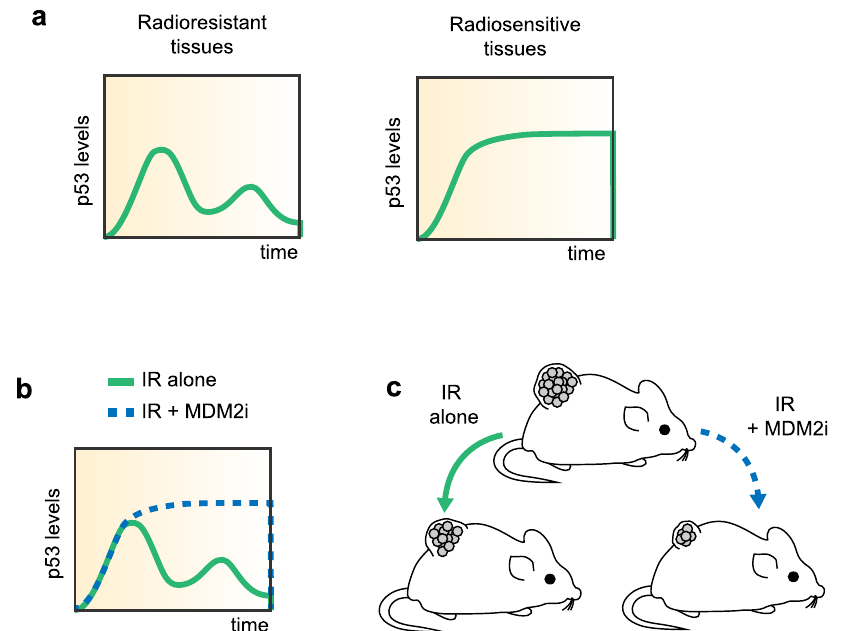
Fig. 5 Schematic of the proposed mechanism for the control of radiation sensitivity of tissues and tumors via p53 dynamics. a Radioresistant tissues, such as the small and large intestines, show transient induction of p53 and oscillatory behavior of its activity and target genes, while the more sensitive tissues, such as the spleen and thymus show sustained levels of p53 after irradiation (IR). b , c Combination of radiation (IR) with the Mdm2